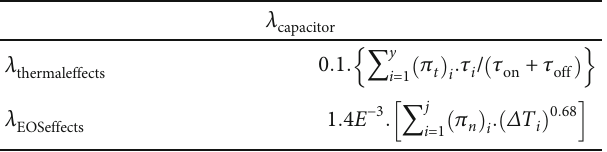
Table 4: Adjustment failure rates for the